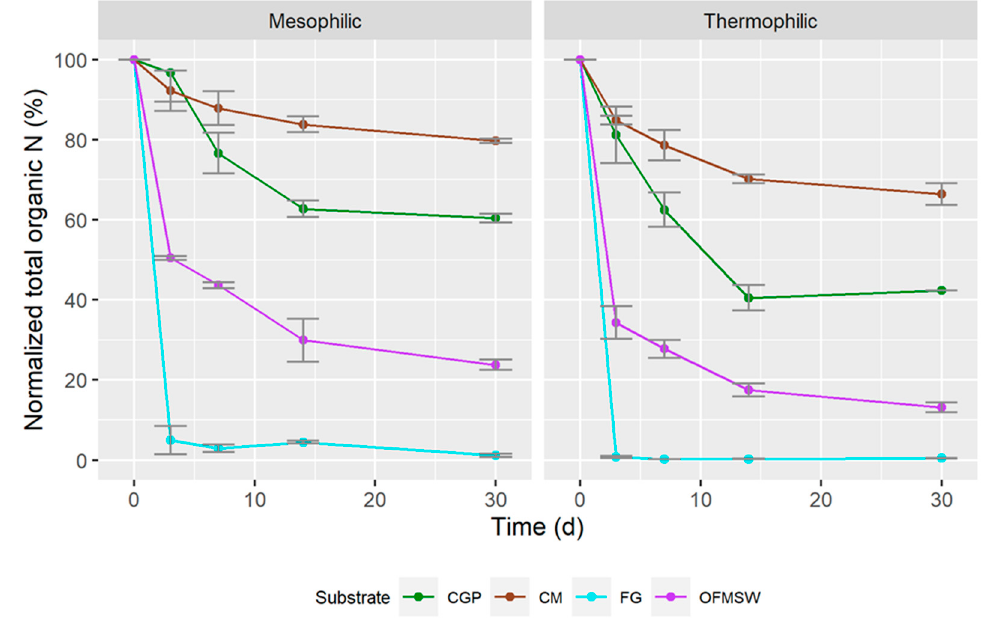
Figure 5. Total nitrogen remaining in Dacron bags over time in continuous experiment. Two different conditions (mesophilic, left and thermophilic, right) are shown with four different substrates. Error bars show standard deviation ( n = 3).